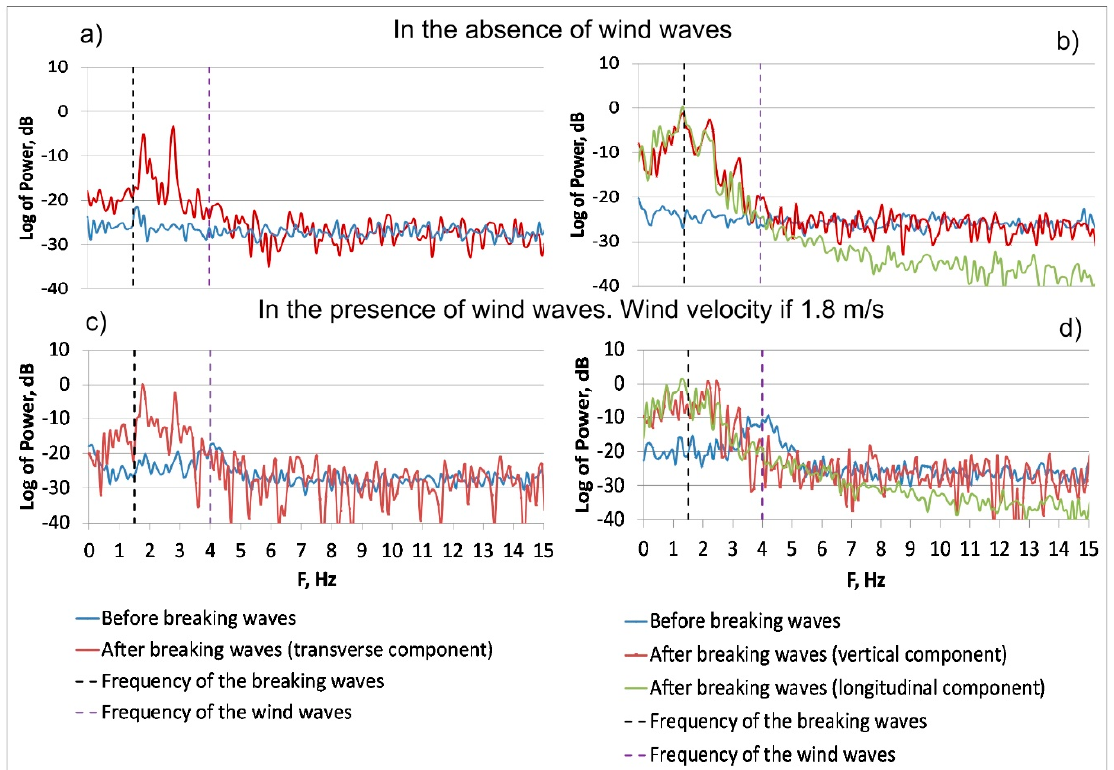
Figure 12. Spectra of transverse ( a , c ) and vertical and longitudinal ( b , d ) velocities in the upper water layer measured with ADV for the case of breaking LF waves in the absence ( a , b ) and in the presence ( c , d ) of wind waves.